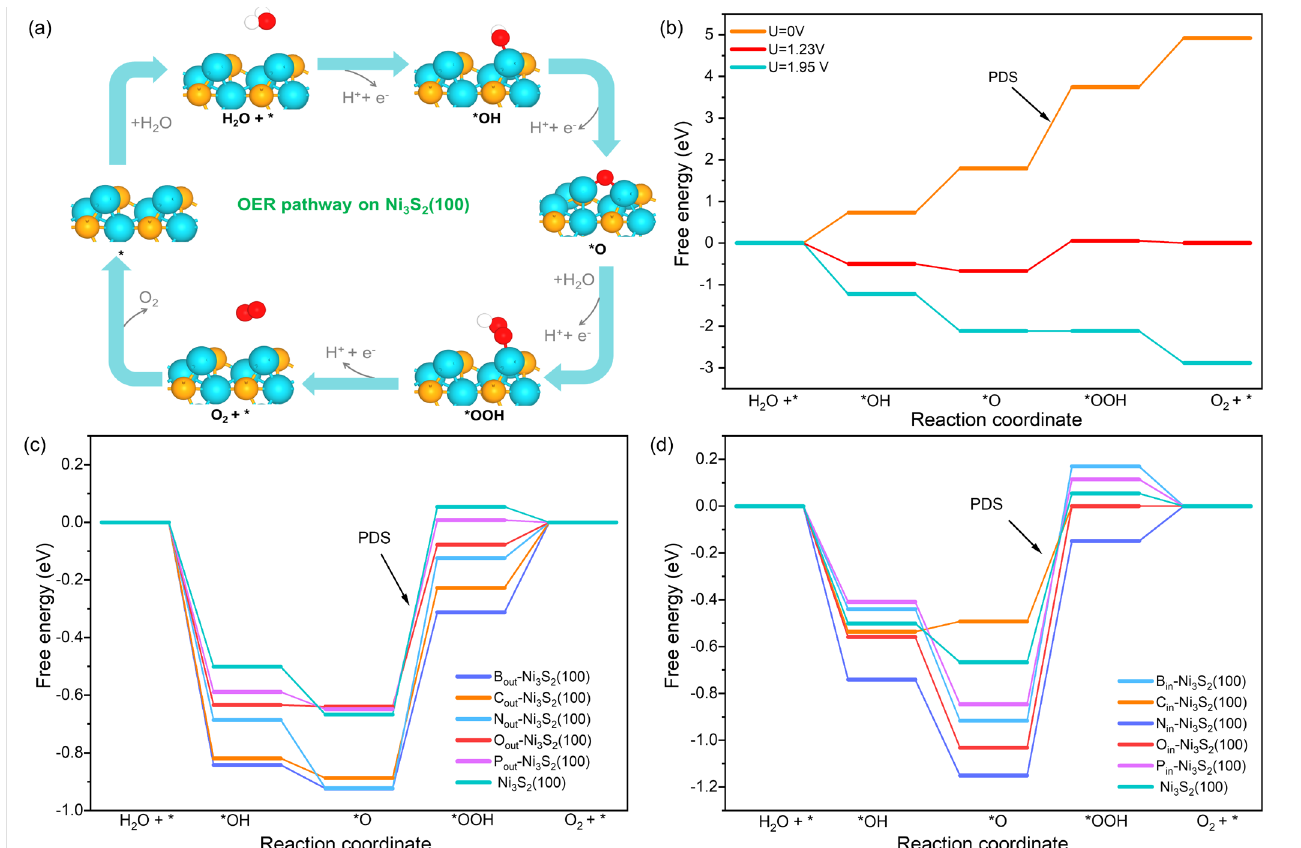
Figure 2. ( a ) The OER process on Ni site of Ni 3 S 2 (100). ( b – d ) Free energy diagrams of OER on Ni1 site of Ni 3 S 2 (100), X out -Ni 3 S 2 (100), and X in -Ni 3 S 2 (100), respectively. (* means surface active site).